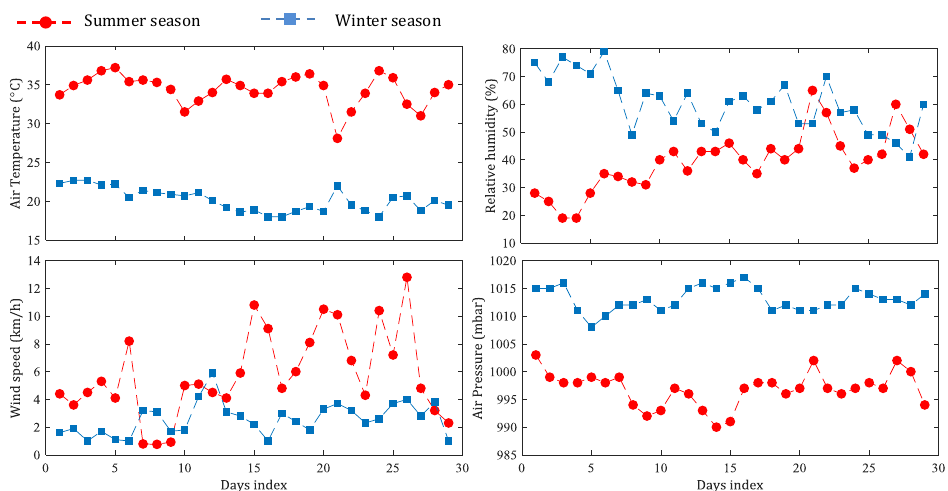
Figure 6. Relation of weather parameters in summer and winter seasons.